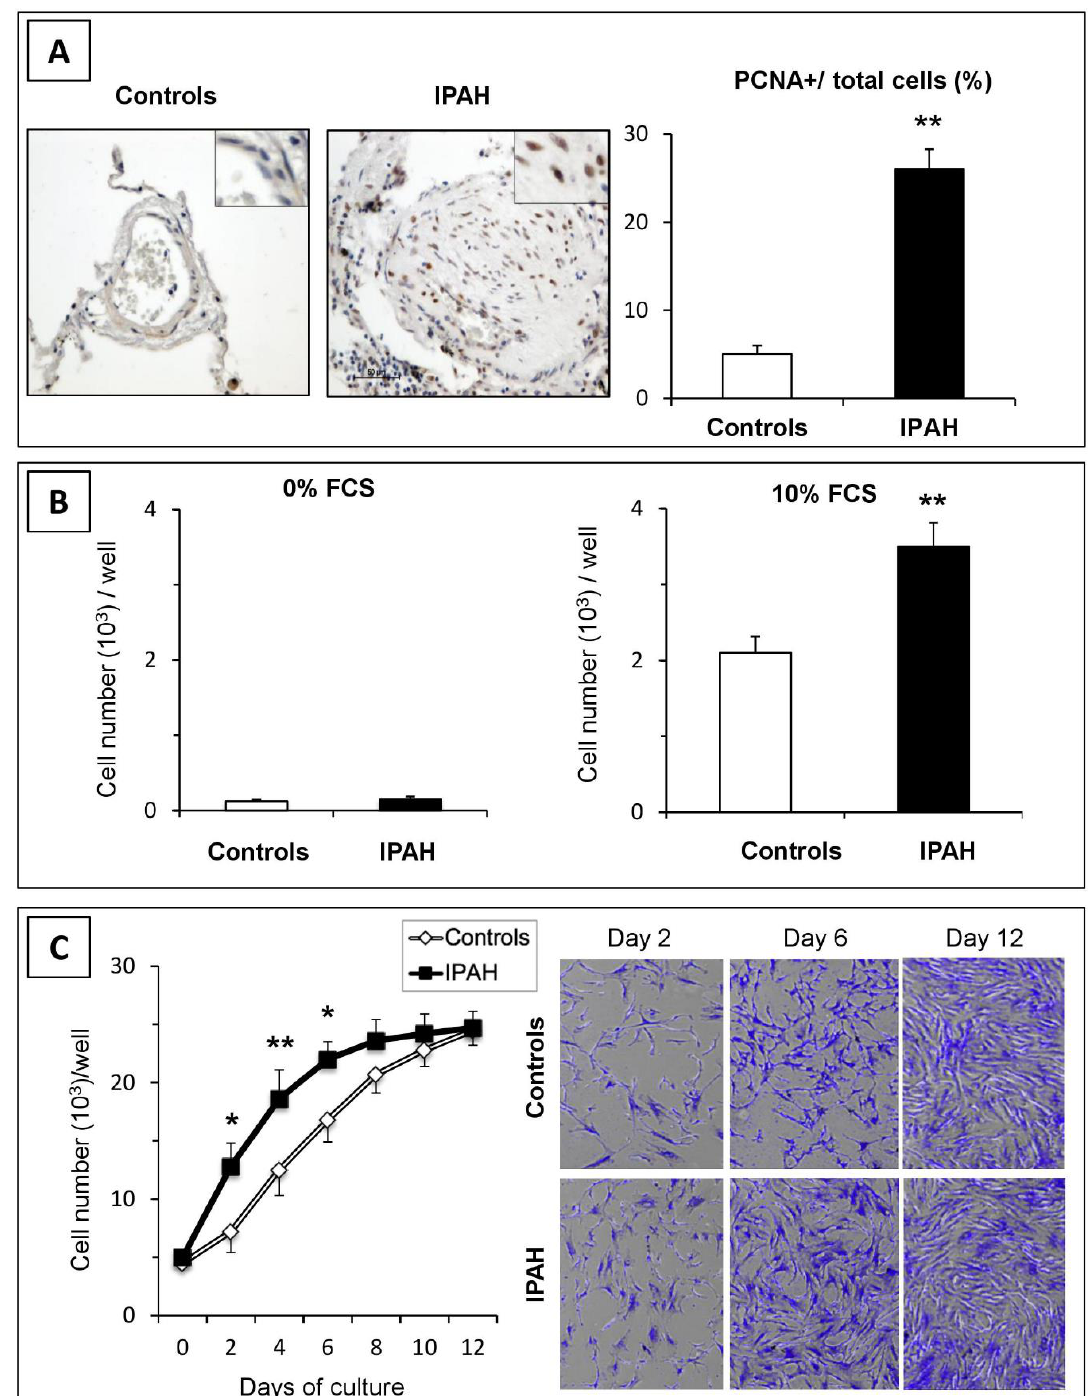
Figure 1. Proliferation of pulmonary vascular cells in idiopathic pulmonary artery hypertension (IPAH). ( A ) In situ cell proliferation in pulmonary arteries from control and IPAH samples was estimated by immunohistochemistry for proliferating cell nuclear antigen (PCNA). Positive cells were more numerous in pulmonary arteries from patients with IPAH than those from controls. ( B ) In vitro proliferation of pulmonary artery smooth muscle cells (PASMCs) cultured without or with 10% FCS for 48 h. ( C ) Cellular growth curves. IPAH-PASMCs grew faster during the exponential phase of growth, but reached a similar density at confluence compared to controls ( n = 6 in each group). * p < 0.05; ** p <